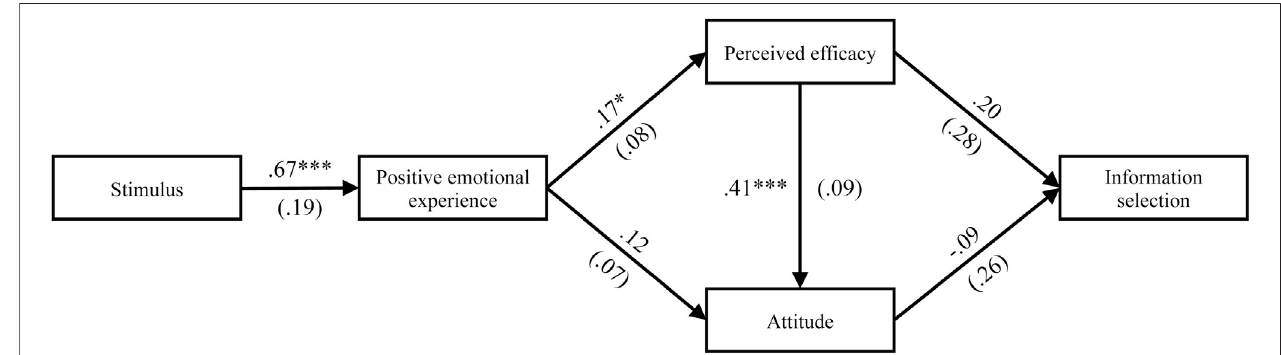
FIGURE 2 | Results Study 1: Effect of the stimulus on actual information seeking mediated by positive emotional experience and perceived ef fi cacy. Stimulus was dummy coded (negative (cid:1) 0, positive (cid:1) 1); positive emotional experience and perceived ef fi cacy(1 (cid:1) don ’ tagreeat all, 5 (cid:1) totally agree); attitude toward healthy nutrition andexercisebehavior(1 (cid:1) unfavorableattitude,5 (cid:1) favorableattitude);informationselectionwasdummycoded(selectionoftopicunrelatedarticle (cid:1) 0;selectionoftopic- related article (cid:1) 1). All regression coef fi cients are unstandardized; standard error in parentheses. * p < 0.05, ** p < 0.01, *** p <